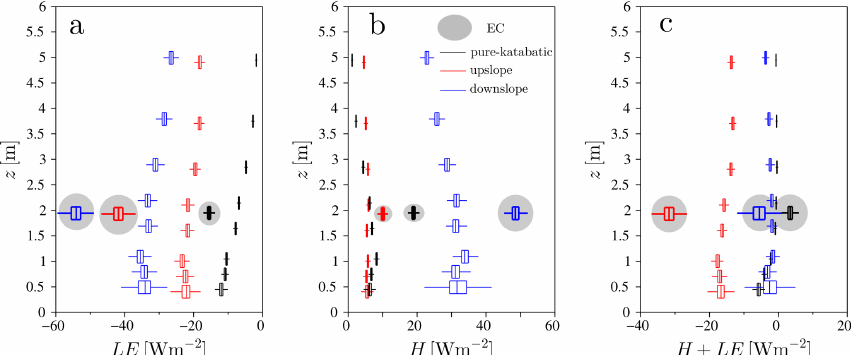
Figure 7. Mean turbulent flux exchange in the “upslope” (red), “pure-katabatic” (black) and “downslope” (blue) wind regimes estimated with the bulk-aerodynamic method and different profile mast levels, plotted against the height of measurement. Results show dispersion from Monte Carlo simulations. The middle line in box plots indicates the median, the boundaries of the boxes the quantiles 25 and 75 and the whiskers the quantiles 5 and 95. Box plots of eddy-covariance (EC) flux influenced by the error estimated using the Mann and Lenschow method are highlighted in grey circles. Results are for (a) latent heat, (b) sensible heat and (c) net turbulent flux.